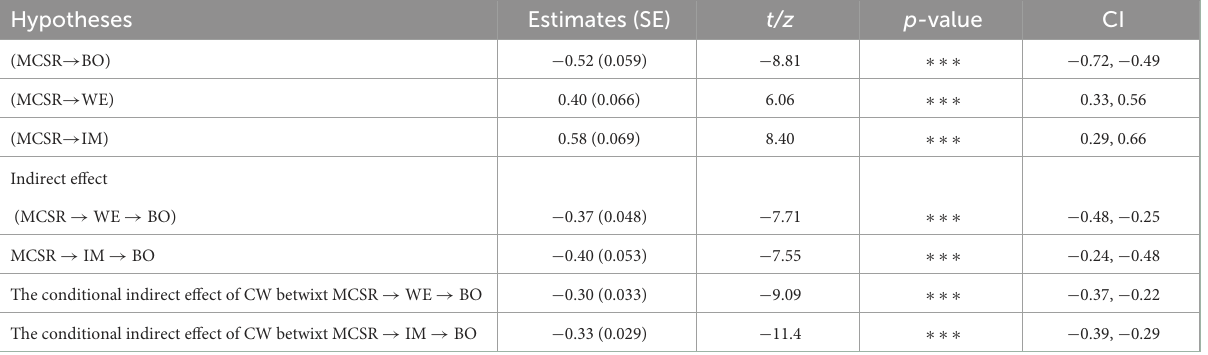
TABLE 6 Hypotheses